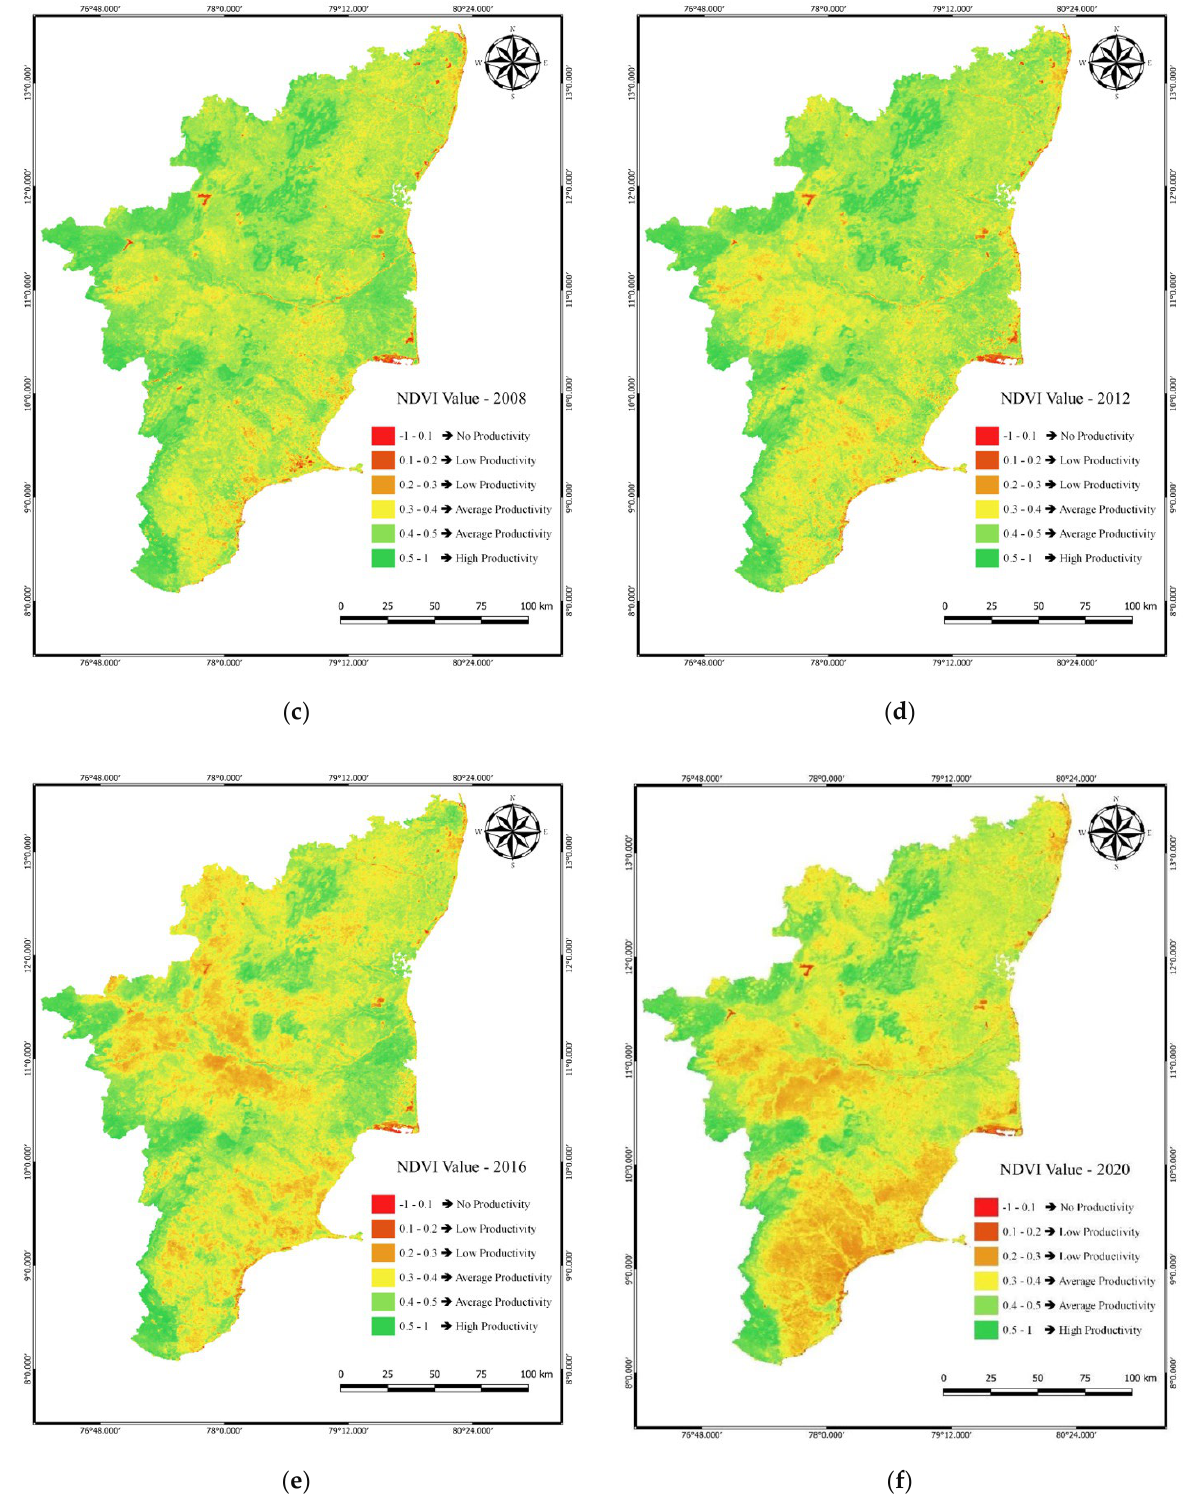
Figure 4. NDVI map for Tamil Nadu depicting the healthiness of the vegetation ( a ) 2000, ( b ) 2004, ( c ) 2008, ( d ) 2012, ( e ) 2016, ( f ) 2020.